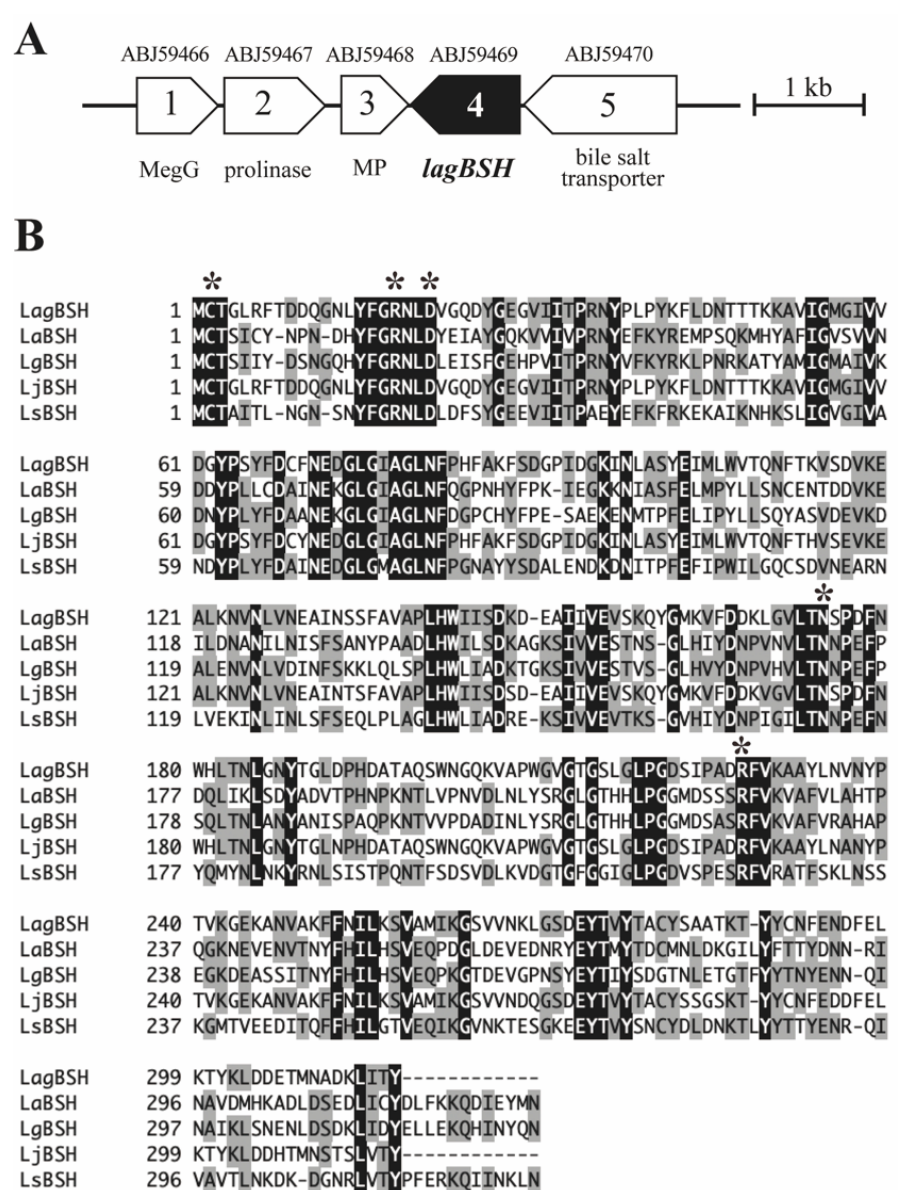
Figure 3. ( A ) Physical map of the predicted bsh gene on the genome sequence of Lactobacillus gasseri JCM1131 T (accession number CP000413). The scale bar indicates a 1 kb length of nucleotide. A putative bsh gene ( lagBSH ) and its surrounding ORFs are represented by filled and open symbols, respectively. Brief annotation and protein ID were provided. MegG, demethylmenaquinone methyl- transferase; MP, membrane protein. ( B ) Multiple alignment of amino acid sequences of BSHs. Amino acid sequence of LagBSH was aligned and compared with known BSHs from Lactobacillus species. The black and gray shading indicates identical and similar amino acid residues, respectively. The conserved residues (Cys, Arg, Asp, Asn, and Arg) relevant to the predicted active site are indicated by black asterisks. Abbreviations: LaBSH (AAV42923) from Lactobacillus acidophilus NCFM; LgBSH (WP_020806888) from Lactobacillus gasseri FR4; LjBSH (AAC34381) from Lactobacillus johnsonii 100-100; LsBSH (JX120368) from Lactobacillus salivarius B-30514.